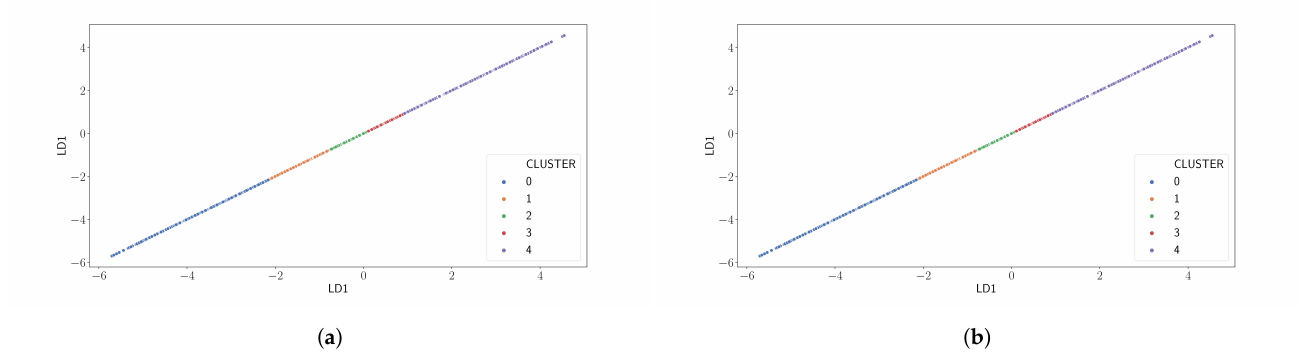
Figure 7. Results from Linear Discriminant Analysis (LDA)+K-Means. ( a ) Using no feedback and I gw as label (Case A) and ( b ) using no feedback and I ack as label (Case D). Table 2. Summary of the clusters distribution for the evaluated cases in LDA+K-Means. Density of data (D), percentage of packets not received/acknowledged (Lost), and percentage of packets received/acknowledged (Recv) in the cluster. Cluster